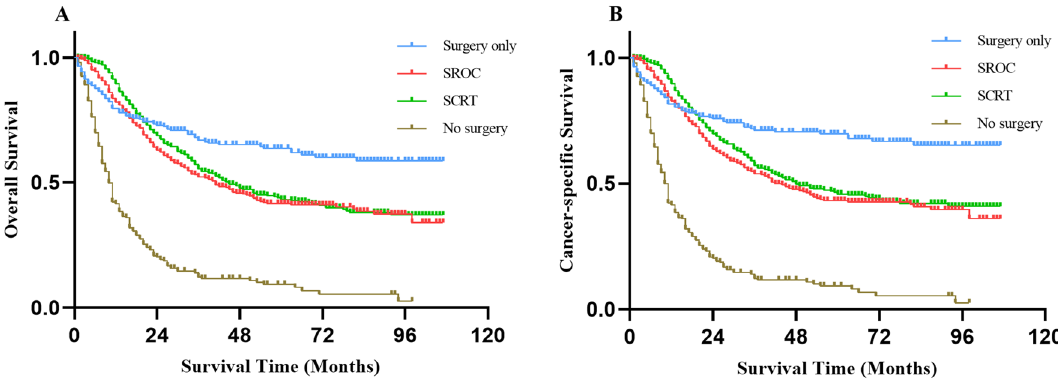
Figure 2. Kaplan–Meier survival curves comparing each treatment for EOGC patients. SROC, surgery plus radiotherapy or chemotherapy; SCRT, surgery plus chemoradiotherapy.